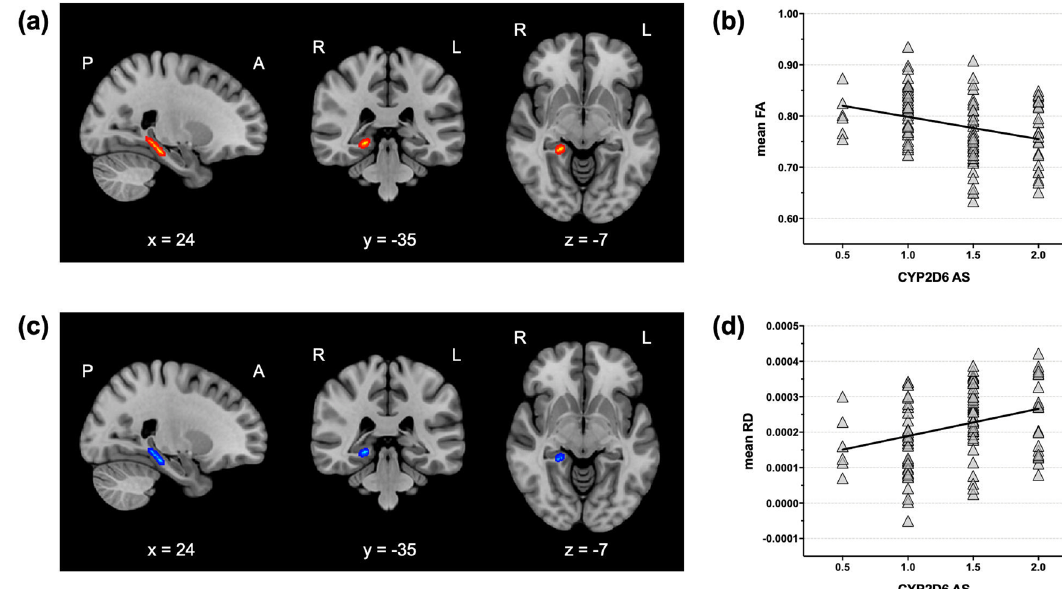
Fig. 2 Comparison of hippocampal white matter connectivity between IM and EM patients with schizophrenia. The IM group showed signi fi cantly increased FAs ( a ) and decreased RDs ( c ) compared to the EM group in the right hippocampal white matter region (TFCE-corrected p < 0.05). The mean FAs ( b ) and RDs ( d ) in this region were signi fi cantly correlated with the activity score of CYP2D6 in participants with schizophrenia. IM intermediate metabolizer, EM extensive metabolizer, FA fractional anisotropy, RD radial diffusivity, TFCE threshold-free cluster